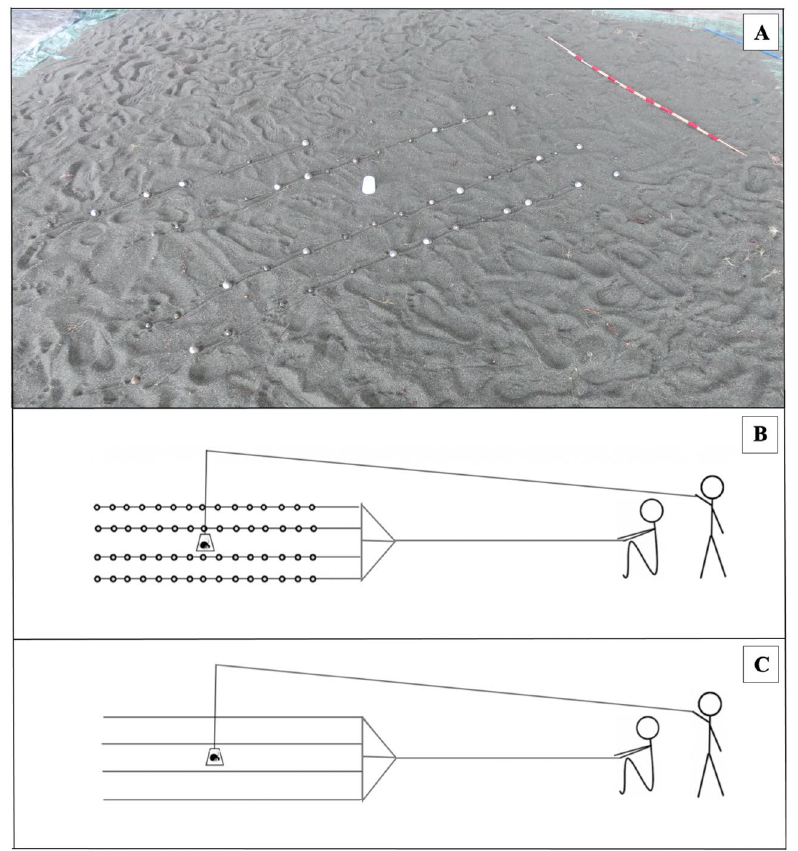
Figure 3. Handled experiments: stimuli and experimental design. ( A ) Photograph of the artificial beach created on a platform adjacent to the natural beach (Photo: Mark Laidre). Photo shows experimental stimulus and an opaque plastic cup in the center, under which a focal crab was placed prior to the start of each experiment. Schematics of stimuli are shown in ( B ) and ( C ). ( B ) Experimental stimuli: consisting of 60 shells arranged in four lines of fifteen, attached to clear fishing line and fixed to a wooden dowel. ( C ) Control stimuli: four empty lines of clear fishing line, fixed to a wooden dowel. The cup was removed by one experimenter from a distance via an attached clear fishing line on a pulley system; the stimulus was then maneuvered by a second experimenter, also from a distance, via another clear fishing